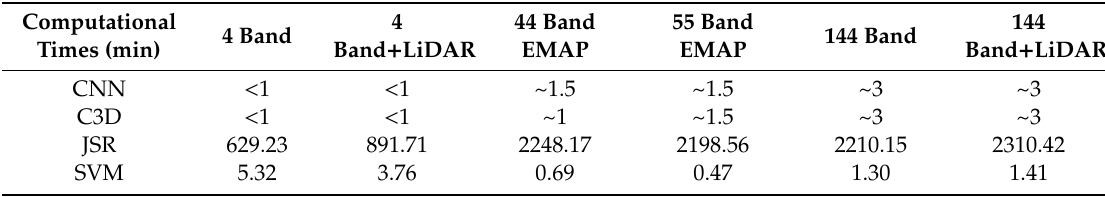
Table 6. Computational times in minutes for di ff erent methods and datasets. CNN and C3D used GPU, whereas JSR and SVM used CPU